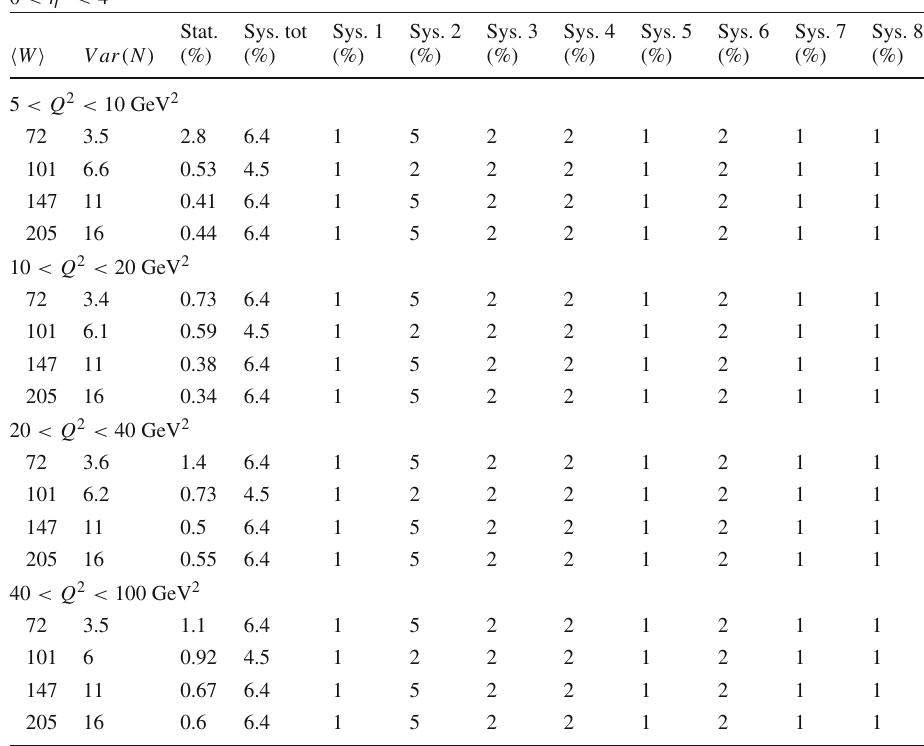
Variance of multiplicity distributions in DIS 0 < η ∗ <